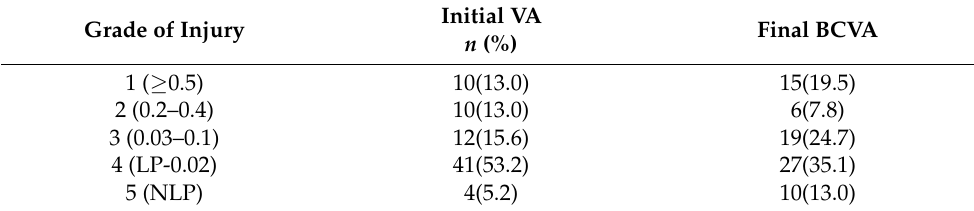
Table 5. Distribution of initial and final visual